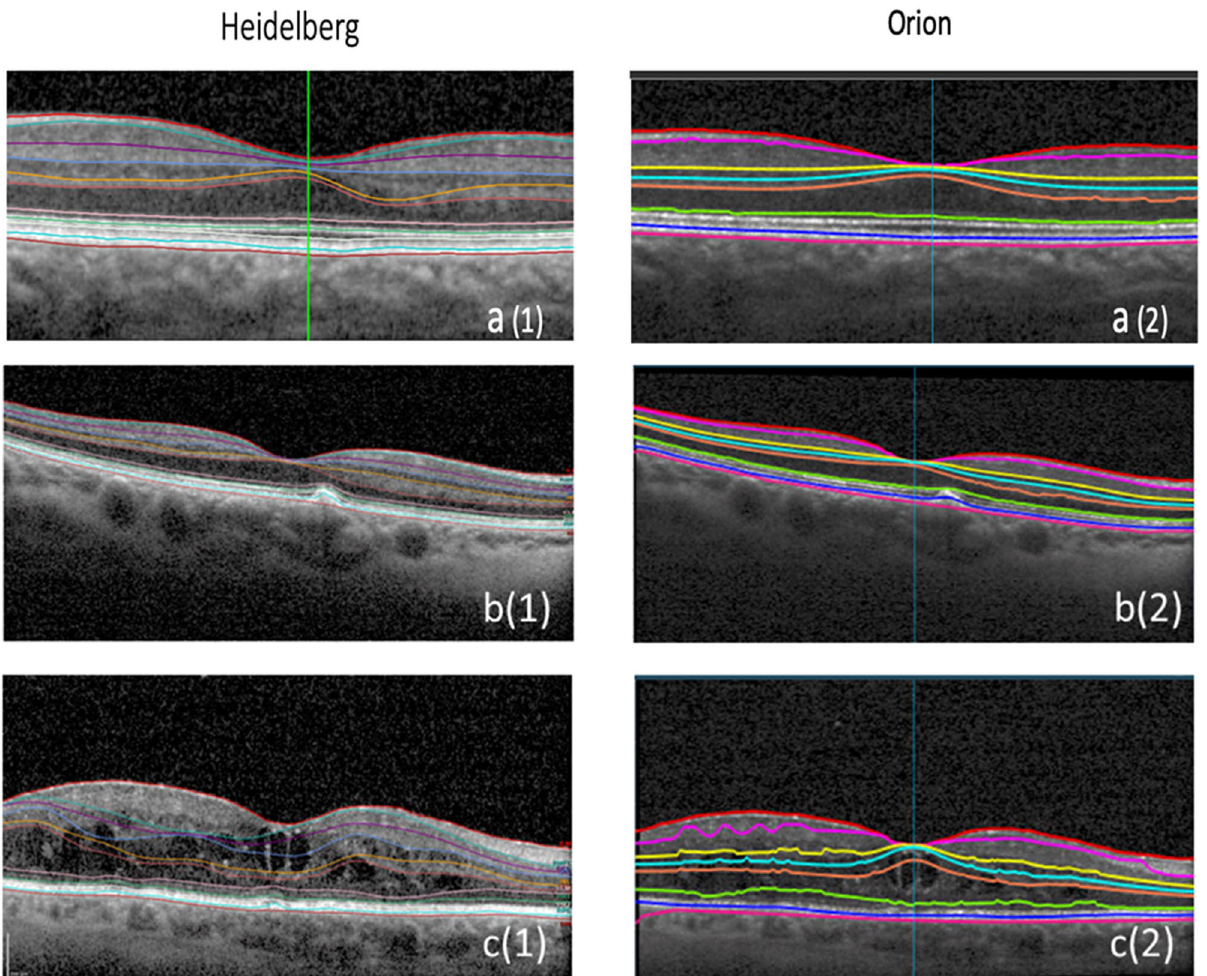
Figure 1. Representative images of retinal segmentation of Normal, Intermediate dry AMD (iAMD) and DME eyes using proprietary software (Heidelberg Spectralis) and automated OCT layer segmentation cross-platform software (Orion). ( a1 ) Normal eyes using Proprietary software, ( a (2)) Normal eyes using Cross platform software, ( b (1)) iAMD eyes using proprietary software, ( b ( 2 )) iAMD eyes using cross platform software, ( c (1)) DME eyes using Proprietary software, ( c (2)) DME eyes using Cross platform